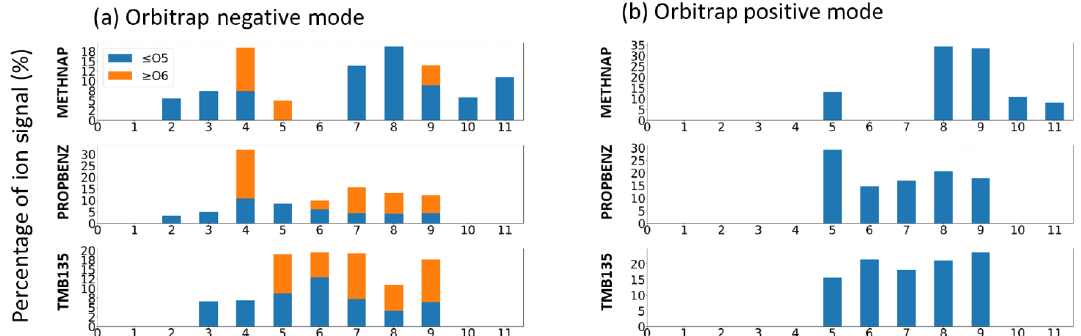
Figure 4. Signal distribution across carbon numbers and coloured by the proportion of HOM signals for (a) Orbitrap negative mode and (b) Orbitrap positive mode. Only signal contributions up to the precursor carbon numbers are included, namely C 9 for TMB135 and PROP- BENZ and C 11 for METHNAP, to capture the relevant products for mechanistic discussions below. Ions which contributed less than 0.5% of observed signal were assumed to be background and